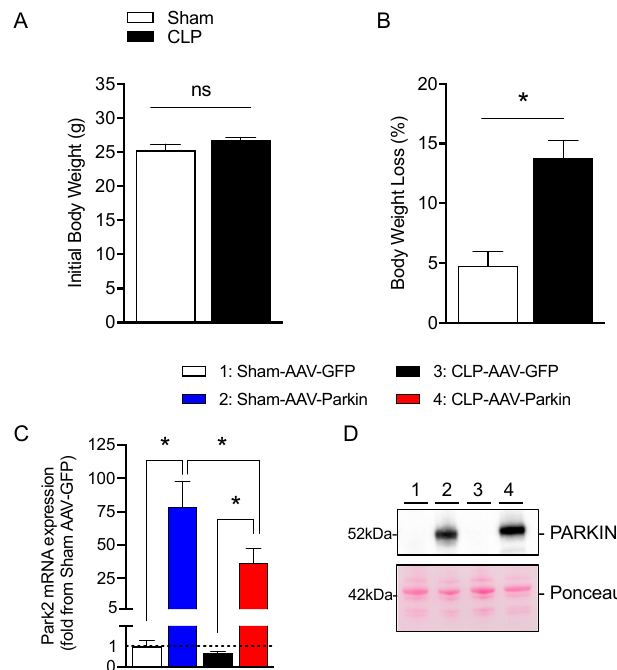
Figure 1. Effective Parkin overexpression in skeletal muscles of Sham and CLP operated mice. ( A ) Initial body weight and ( B ) percent of body weight loss in Sham-operated and or CLP mice. ( C ) qPCR analysis of Park2 expression levels in the gastrocnemius muscles injected with either AAV-GFP or AAV-Parkin in Sham and CLP mice. ( D ) Representative Parkin immunoblots